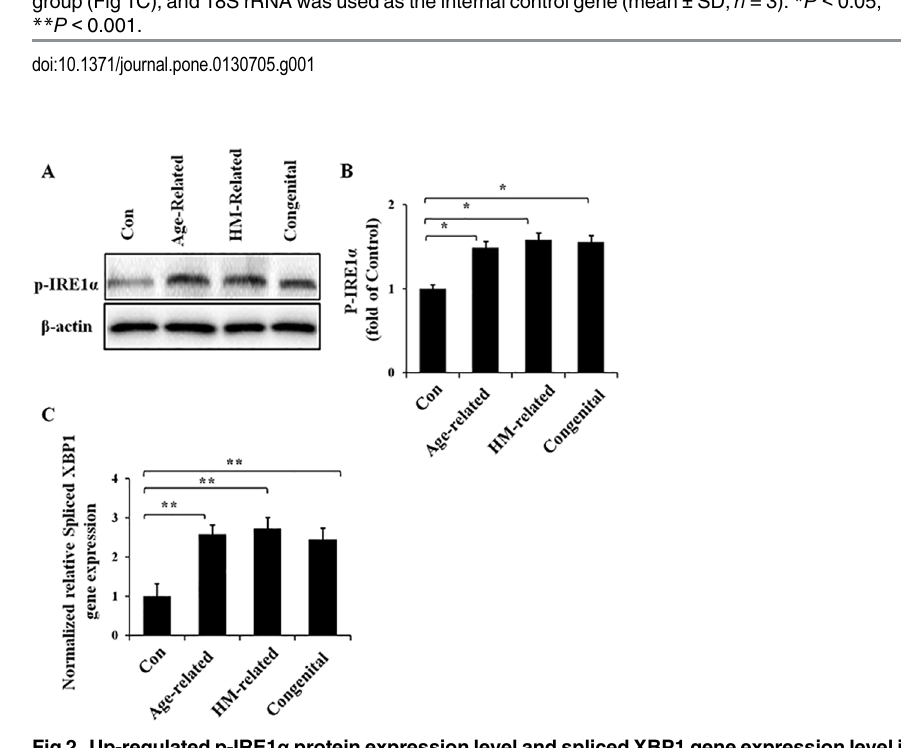
Fig 2. Up-regulated p-IRE1 α protein expression level and spliced XBP1 gene expression level in the different cataract lens groups RNA and protein were extracted from human lens specimens. Western blotting was performed to detect the protein expression of p-IRE1 α (Fig 2A, Fig 2B), and β -actin was used as the internal control; real-time PCR was performed to detect the relative gene expression levels of spliced XBP1 in each group (Fig 2C), and 18S rRNA was used as the internal control gene (mean ± SD, n = 3). * P < 0.05; ** P < 0.001.